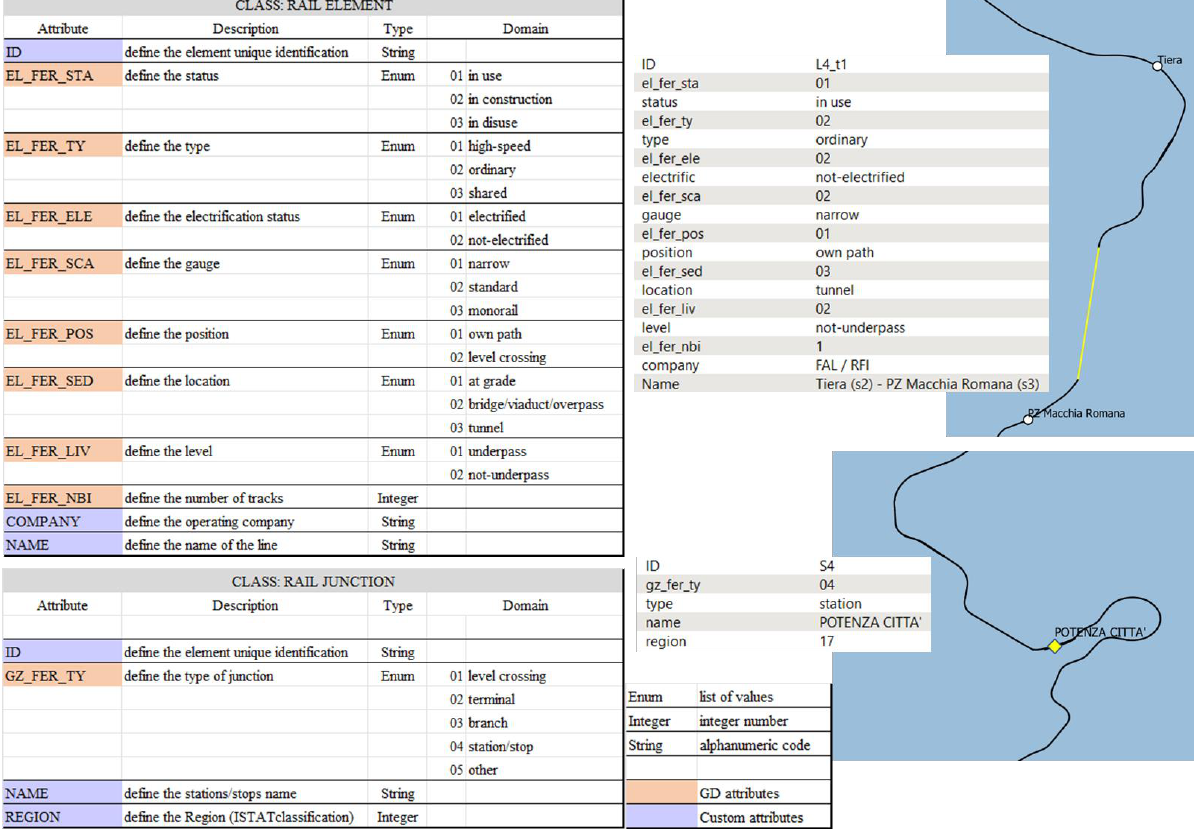
Figure 5 . Rail lines and junctions classification; tunnel and station attribute